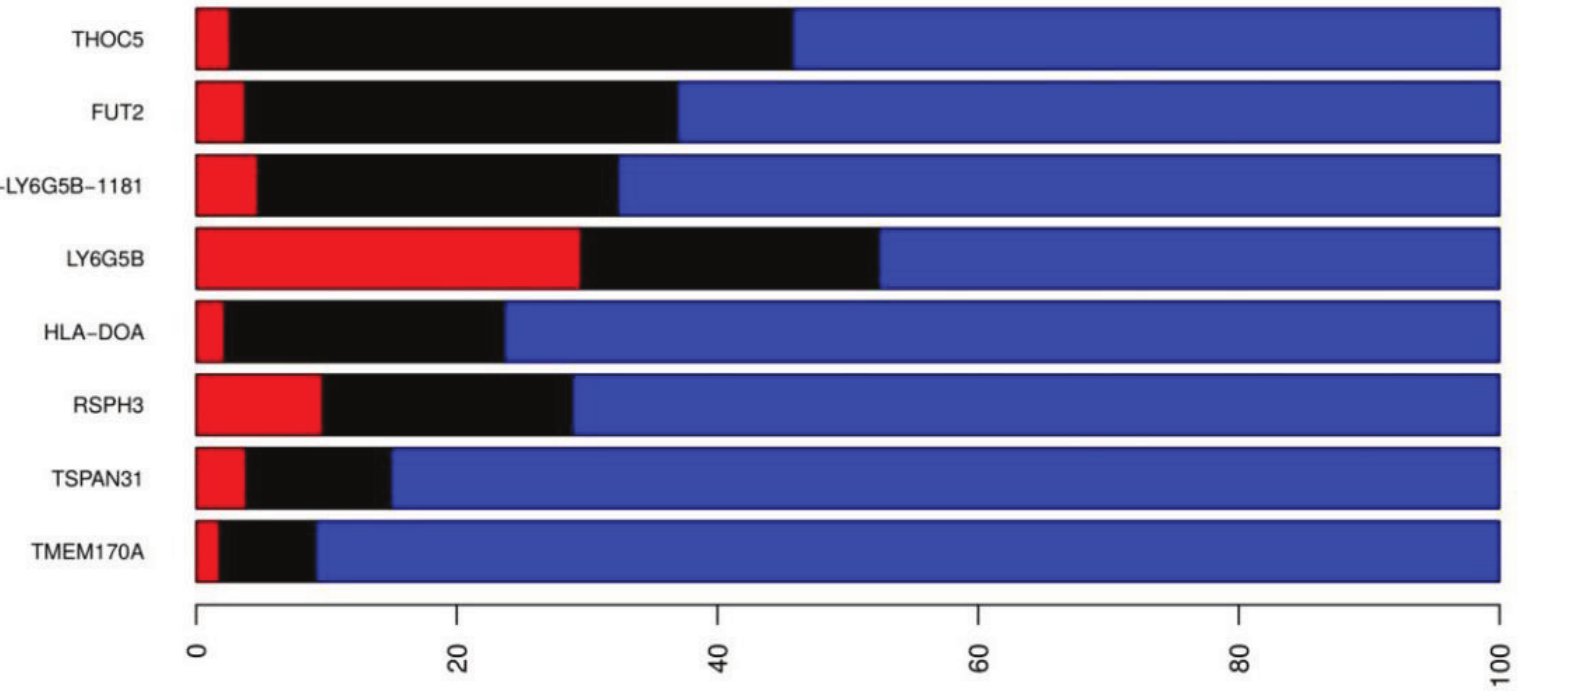
Figure 2. Contribution of UTRs and CDS to the length of T1D mRNAs harboring IRAlus. The contribution of 5'UTR, coding (CDS), and 3'UTRs to the total length is shown for eight T1D genes harboring IRAlus within their 3'UTRs. Only the protein-coding isoforms listed in Table 4 are shown. Transcripts are ranked according to the percentage of mRNA contributed by CDS. For genes with more than one protein-coding isoform, only the major isoform is shown. The x-axis represents the percentage of sequence coverage for each gene on the